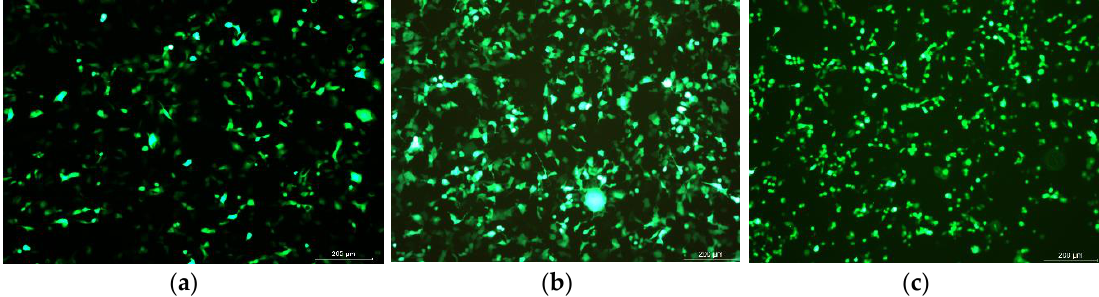
Figure 3. Green fluorescent protein (GFP) fluorescence protein expression in the HEK 293 cells (( a ): 24 h, ( b ): 48 h, ( c ): 72 h).